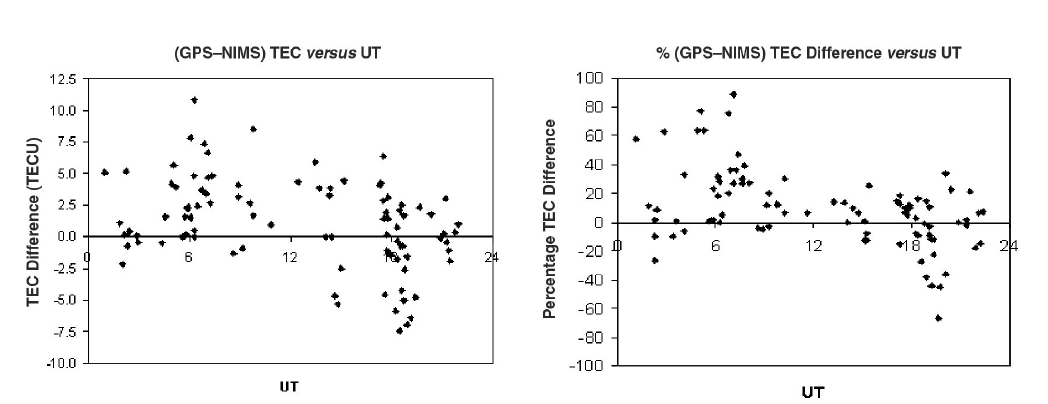
Fig. 8.3. Difference between GPS-TEC and NIMS-TEC estimates as a function of UT expressed in absolute and percentage